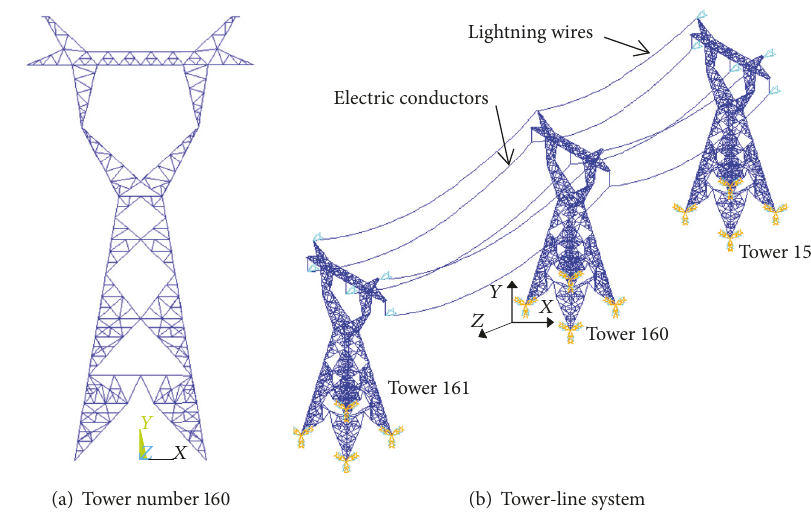
Figure 3: Finite element analysis model of the high-voltage transmission tower-line system.